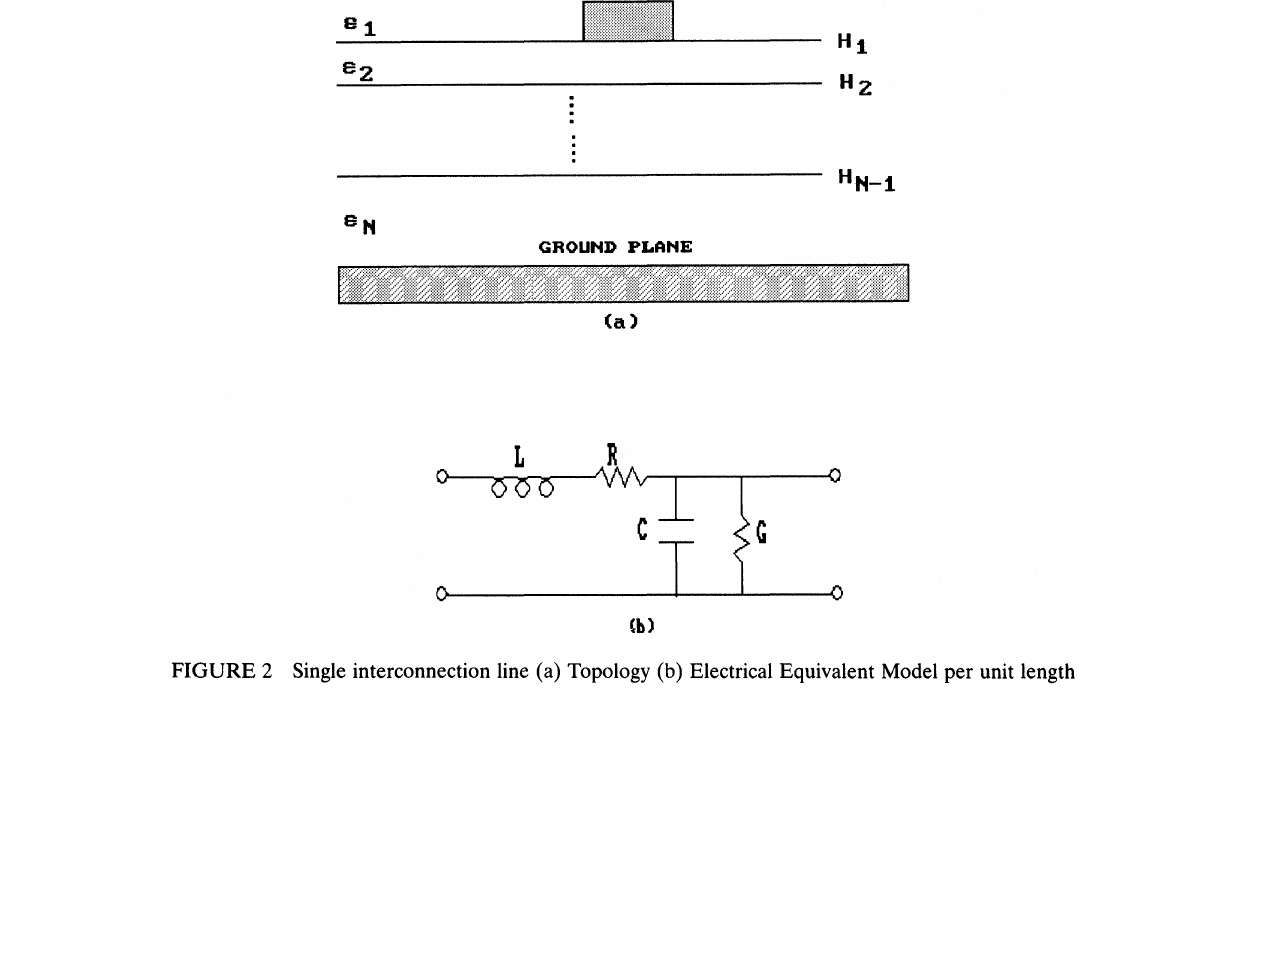
FIGURE 2 Single interconnection line (a) Topology (b) Electrical Equivalent Model per unit